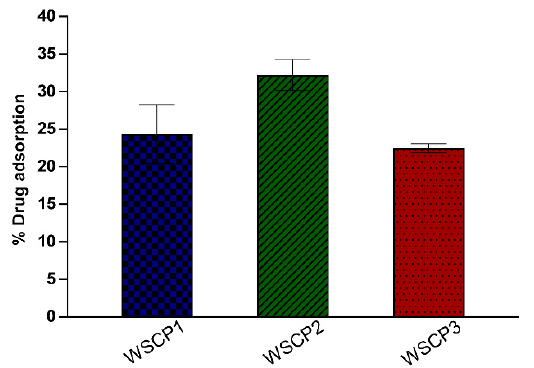
Figure 3. Percentage WSCP1-3 adsorption into Montmorillonite (VHS). Each experiment was repeated three times and error bars represent the standard deviation.